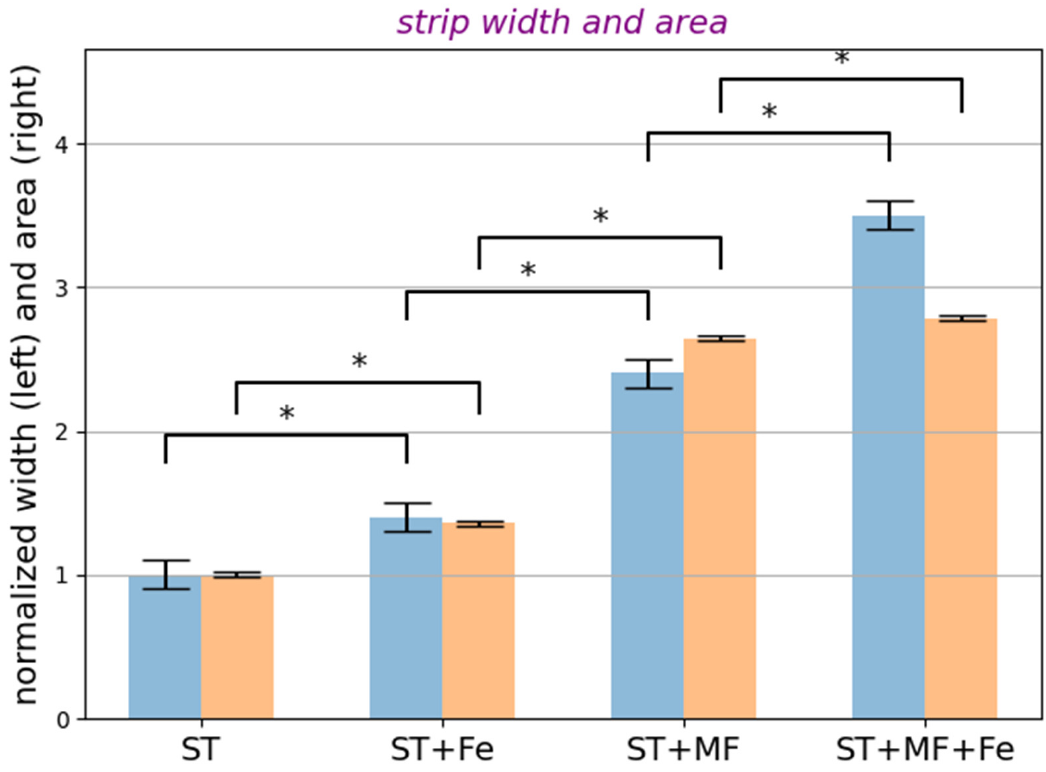
Figure 7. Width and surface area (both normalized to the controls) of the strips, formed by the EcN cell just above the contact surface of the system of two permanent magnets: ST—standard medium (control), ST + MF—standard medium in the external 0.15 T MF, ST + Fe—standard medium with iron chelates, ST + MF + Fe—standard medium with iron chelates in the external 0.15 T MF. The examples of optic images of strips of magnetic focusing of EcN bacteria in a gradient MF above the contact surface of the two permanent magnets are presented in Figure 4. Blue bars represent the mean strip width, while the orange bars are the mean strip area measured using the optic images and the Gwyddion free software [54]. The asterisk (*) means P values less than 0.05.